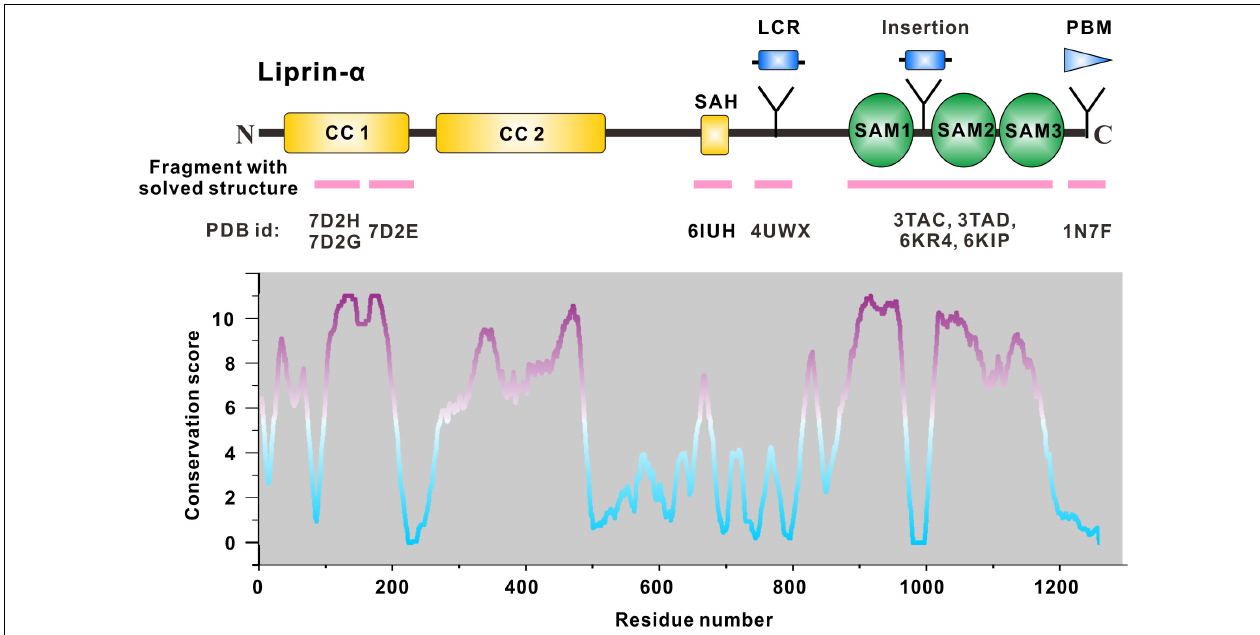
FIGURE 1 | Domain organization of liprin- α . The diagram depicts the domains or regions of liprin- α . CC, coiled-coil region; SAH, single alpha helix; SAM, sterile- α -motif domain. Isoform or species-specific regions were shown above the schematic diagram. LCR, a liprin α 3 core region in liprin- α 3; Insertion, an inserted loop region in liprin- α 2/3/4; PBM, a PDZ binding motif in vertebrate liprin- α s. Regions of liprin- α with solved structure were highlighted by pink lines under the diagram. PDB ids were shown under the pink lines (7D2H and 7D2G for liprin- α 2_H2, 7D2E for liprin- α 2_H3; 6IUH for the liprin- α 2_SAH/GIT1_PBD complex; 4UWX for the liprin- α 3_LCR/mDia_DID complex; 3TAC, 3TAD, 6KR4, and 6KIP for the SAM123 structures in complex with CASK_CaMK, liprin- β 1_SAM123, LAR_D1D2, and PTP δ _D2, respectively; 1N7F for the liprin- α 1_PBM/GRIP1_PDZ6 complex). The value curve at the bottom panel indicates sequence conservation of liprin- α proteins. The conservation score for each residue was calculated in Jalview (Waterhouse et al., 2009) using the sequence alignment of liprin- α family members across species, including Caenorhabditis elegans, Drosophila melanogaster, Danio rerio, Xenopus tropicalis, Gallus gallus, Mus musculus, and Homo sapiens . The scores from 0 to 11 indicate the most variable to the most conserved state of each residue, colored from cyan to purple